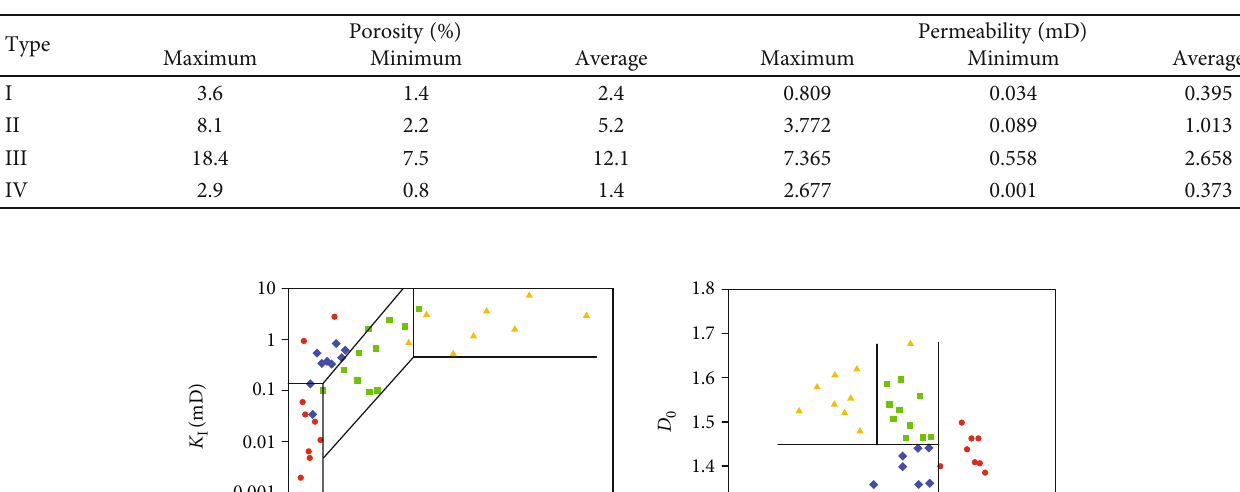
Table 4: The statistical results of porosity and permeability in di ff erent classes based on K -means clustering analysis with multifractal parameters.